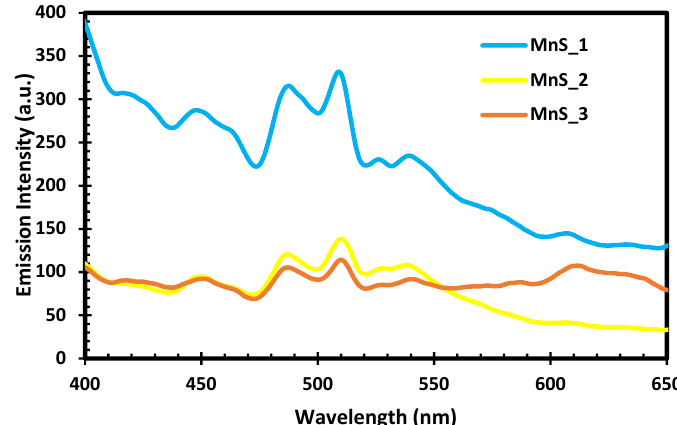
Figure 5. PL spectra of MnS_1, MnS_2 and MnS_3